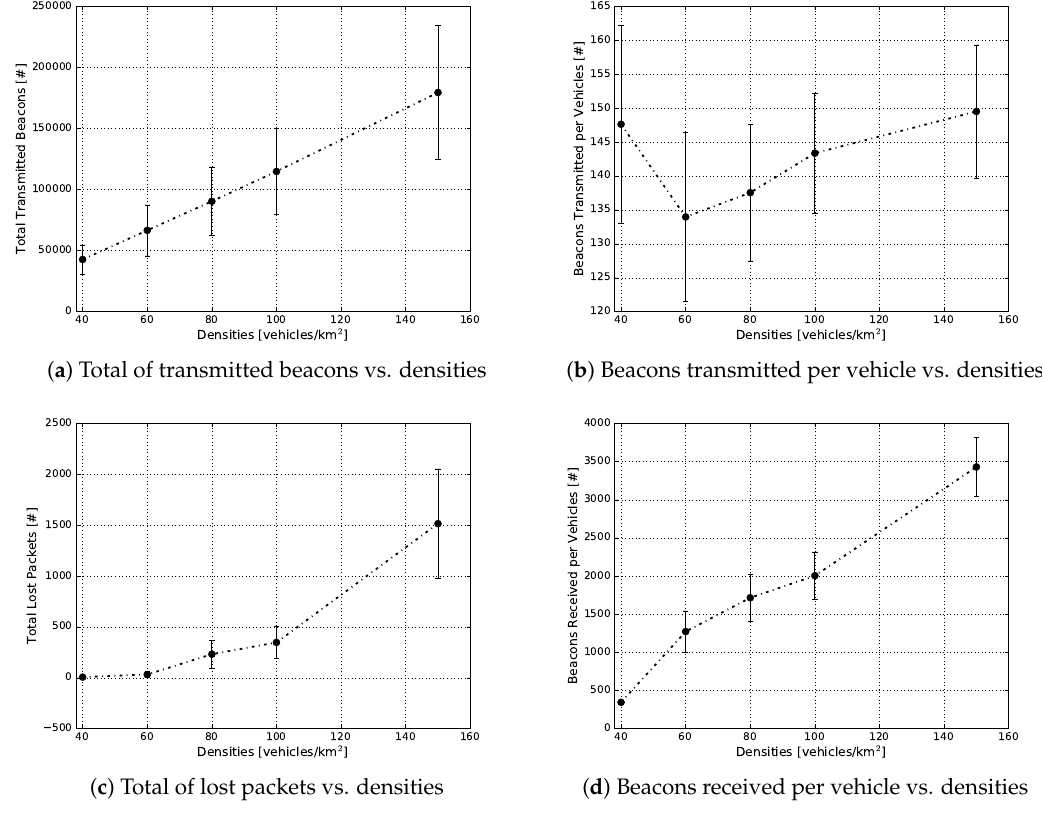
Figure 13. Performance evaluation of the network under different traffic